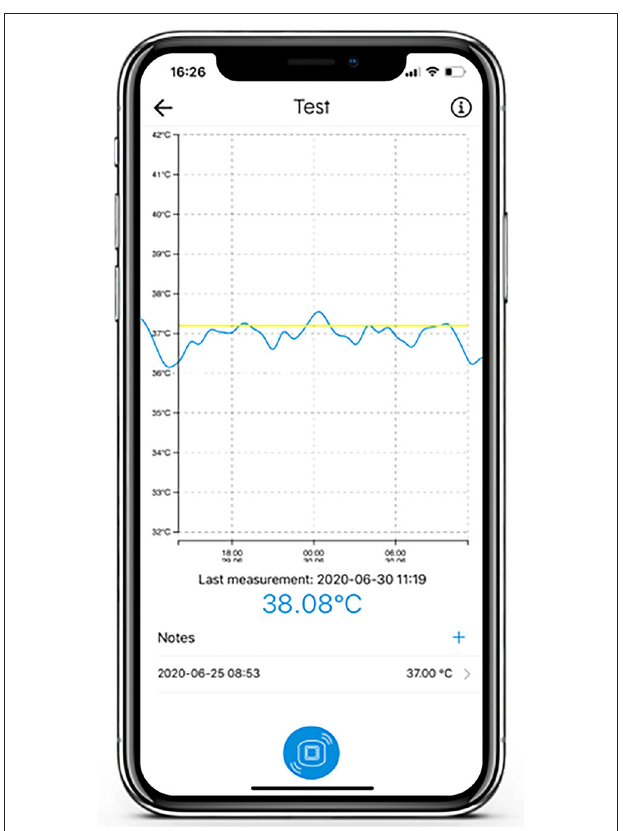
FIGURE 2 | Surface of the Steady Temp app.